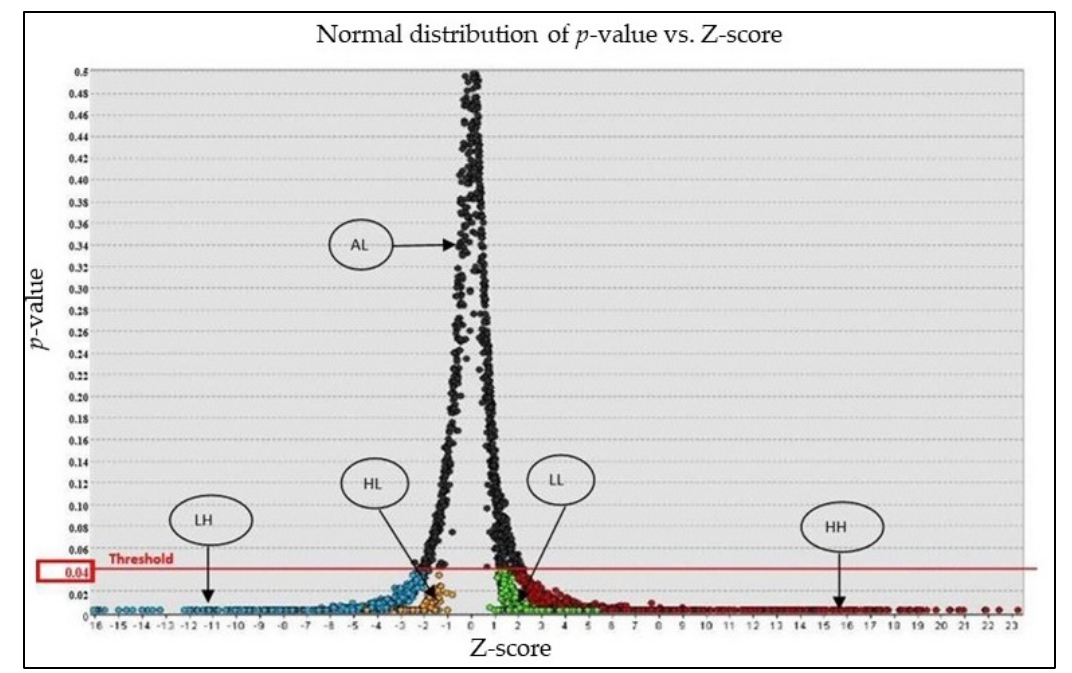
Figure 8. Spatial autocorrelation curve ( p ‐ value vs. Z ‐ score) of Nb ‐ Ta mineralized gravel samples (AL: black dots; LH: blue dots; HL: orange dots; LL: green dots, and HH: red dots).